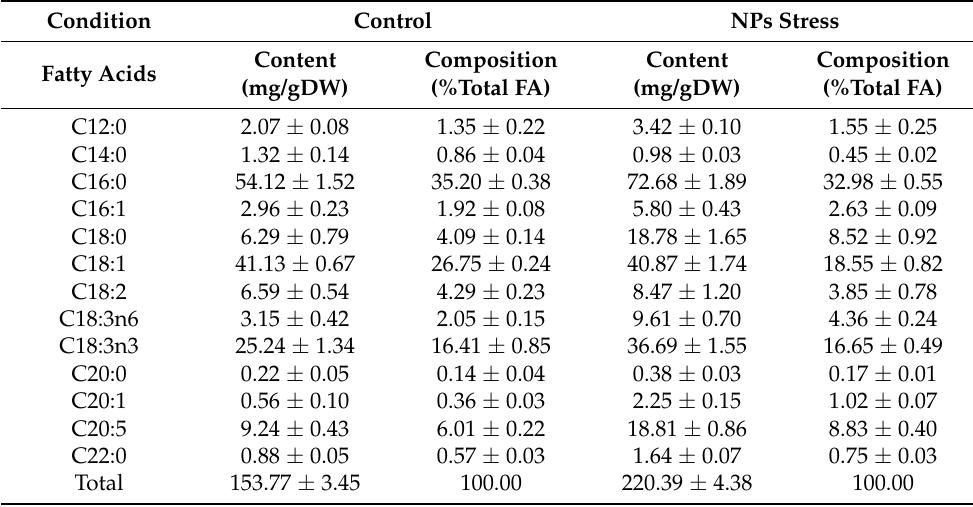
Figure 12. The effect of the concentration change of NPs from low (20 mg/L) to high (100 mg/L) on the growth, lipid content, and lipid production of Chlorella sp. UJ-3 (NP concentration change was conducted on day 12). Table 1. Fatty acid contents and compositions of Chlorella sp. UJ-3 under control conditions and NP stress.